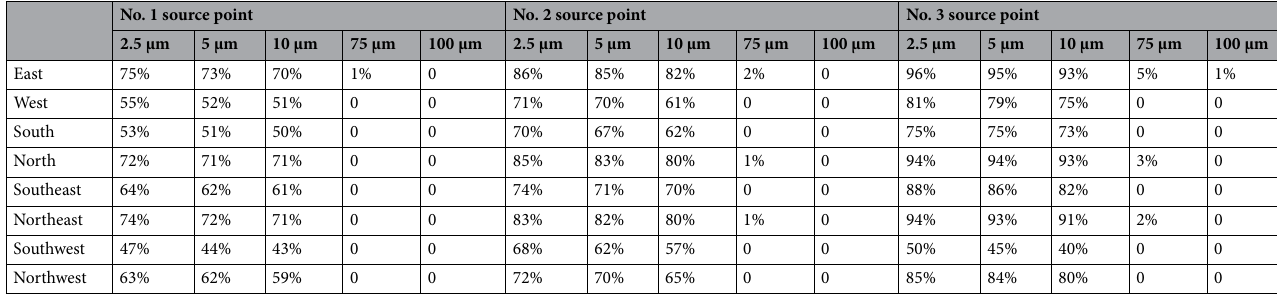
Table 3. The dispersion rate of dust particles at each source point under different wind